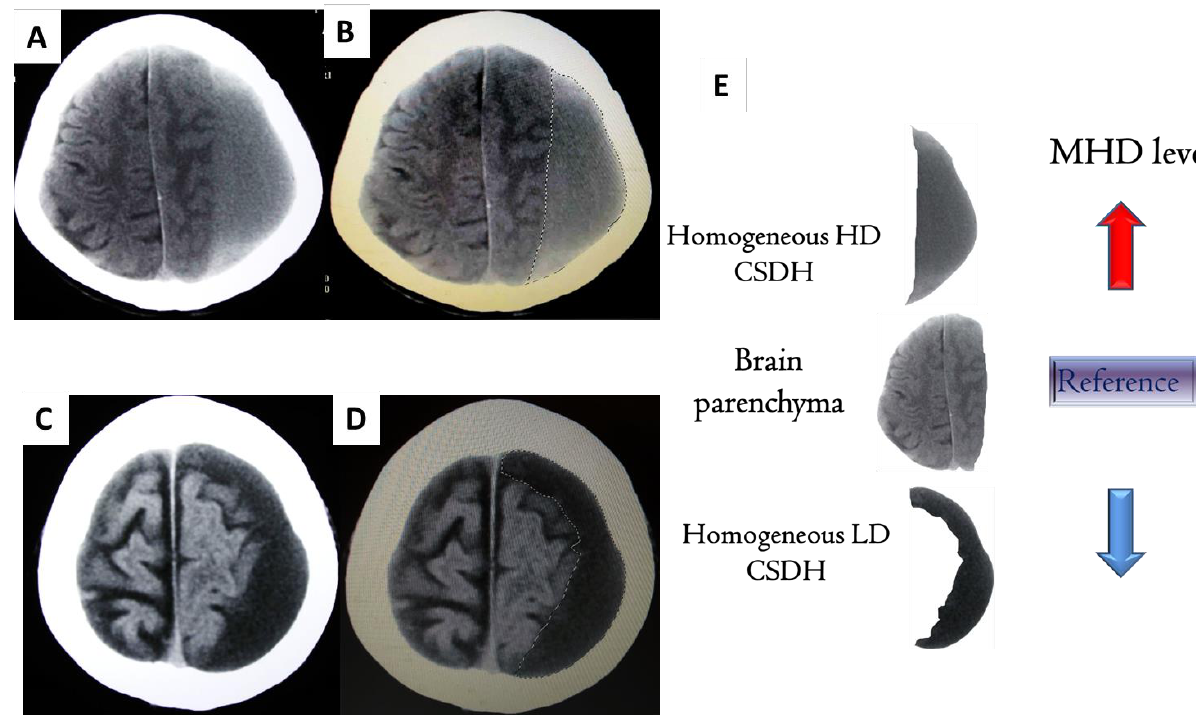
Figure 1. Representative CT scan of homogeneous hyperdense (HD) and hypodense (LD) chronic subdural hematoma (CSDH). Initial CT scans of patients with CSDH, homogeneous for HD ( A ) and LD ( C ) types showed that the density levels of the hematomas were higher and lower, respectively, than the brain parenchyma. As shown in ( B , D ), for each CT axial slice, the boundary of the CSDH is outlined under the PACS system and the density of the hematoma is computed and presented as Hounsfield units (HU). After determining the hematoma density for each axial section, the mean he- matoma density (MHD) is calculated individually for each patient according to the formula. ( E ) Previ- ous studies have shown that high values of MHD imply a high likelihood of hematoma instability, in- cluding hypervascularity, the production of a neomembrane, and even a high bleeding tendency. As shown in the schematic, although classified as homogeneous, the two types of hematomas, HD and LD, have vastly different MHD values.